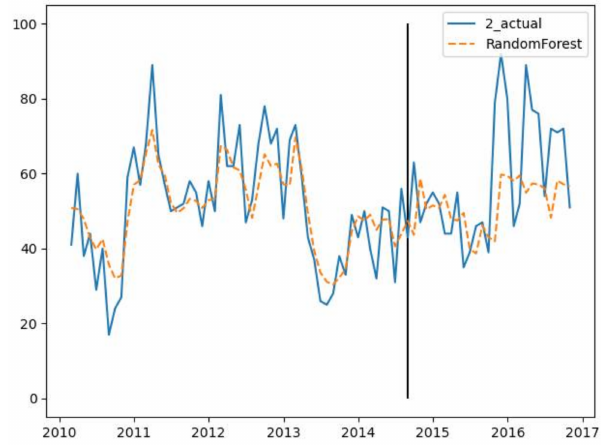
Figure 9. Random forest’s fitting and prediction results for group 2.